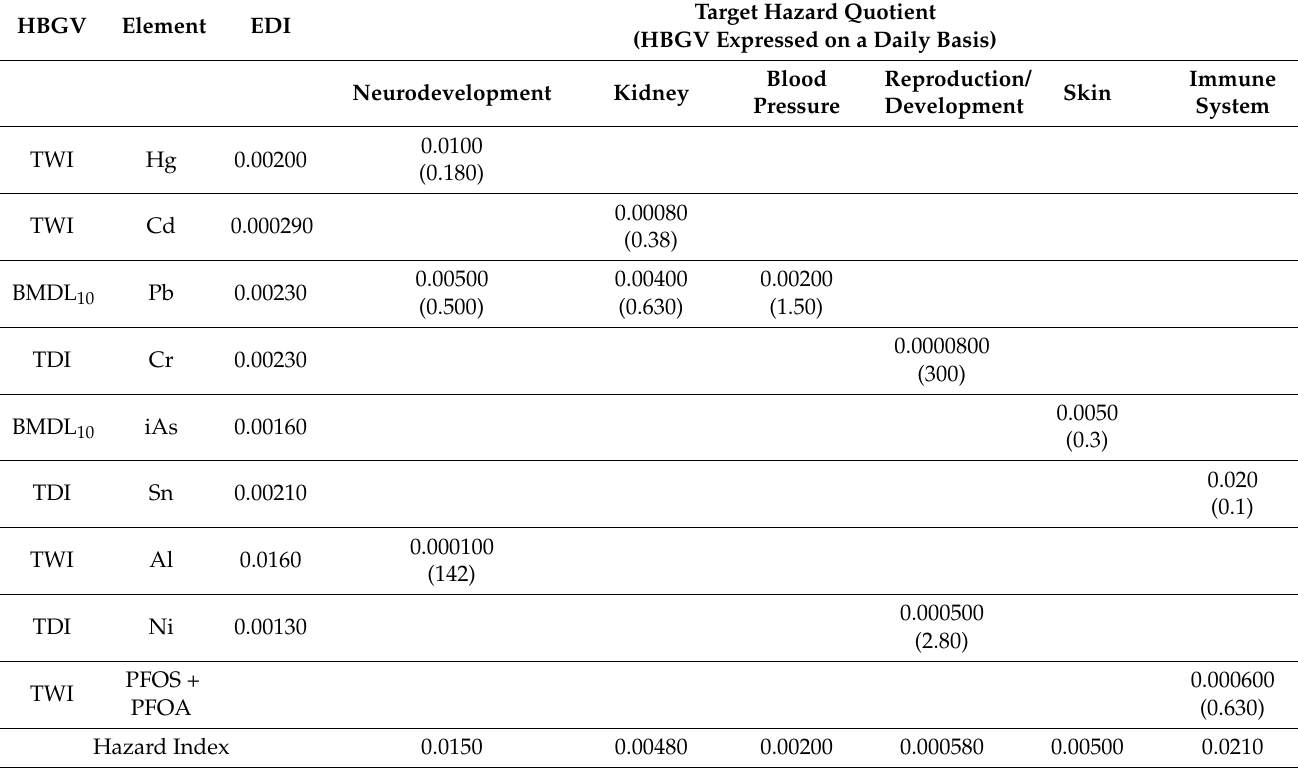
Table 9. Hypothetical target hazard quotients and hazard indexes for the estimated daily exposure (EDI) through preserved anchovies at the highest concentrations detected. All the Health-Based Guidance Values (HBGVs) are by EFSA. TWIs are recalculated and expressed on a daily basis. As is reported as inorganic arsenic and only Cr (III) is considered. EDI and HBGV are expressed as